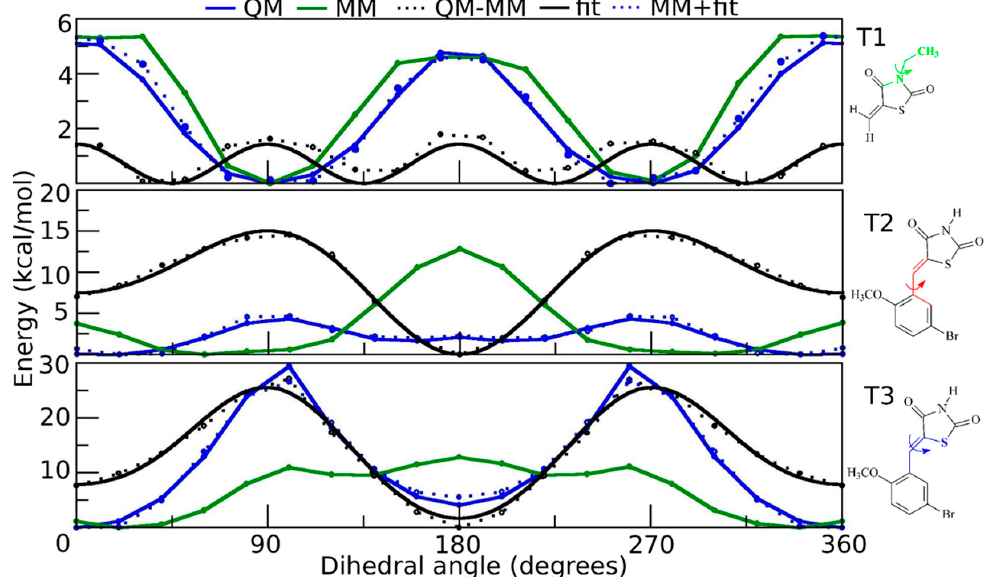
Figure 3. Potential energy curves generated for the torsions T1, T2, and T3 of the GQ16 molecule. The values of the potential energy computed by density functional theory are represented by the blue line (QM), whereas the corresponding values generated from the classical potential are represented by the green line (MM). The QM and MM energy differences are depicted by the black dotted line; the solid lines are the fitted dihedral potentials; the blue dotted lines are the sum MM and fitted dihedral potential. The structures on the right side of each graph depict the fragments used to calculate the potential energy curves (the calculated dihedrals are colored).